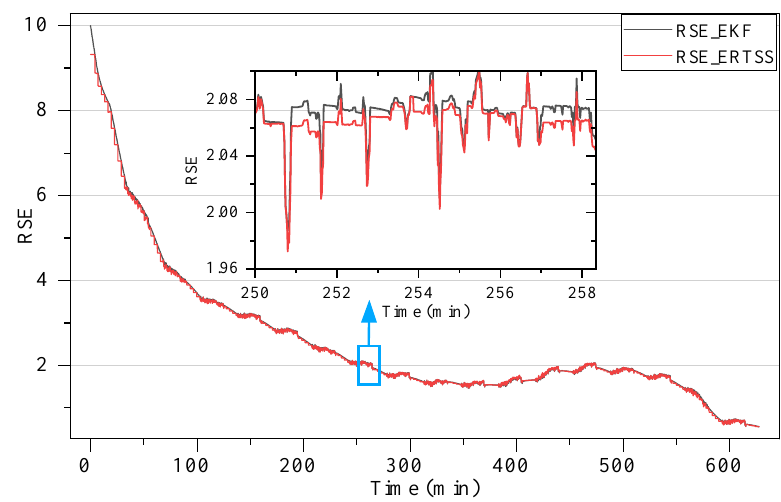
Figure 12. RSE of ERTSS and EKF at 25 ◦ C. Figure 13 depicts the SOC estimation RMSE of EKF at various temperatures. As dis- cussed in (56), RMSE is a statistical result of the RSE, so RMSE reflects the error fluctuation somehow. ERTSS’s RMSE is lower than EKF at all temperatures, so the estimation of SOC by ERTSS is more precise than EKF. Specifically, ERTSS can reduce the RMSE of SOC estimation by about 5% based on